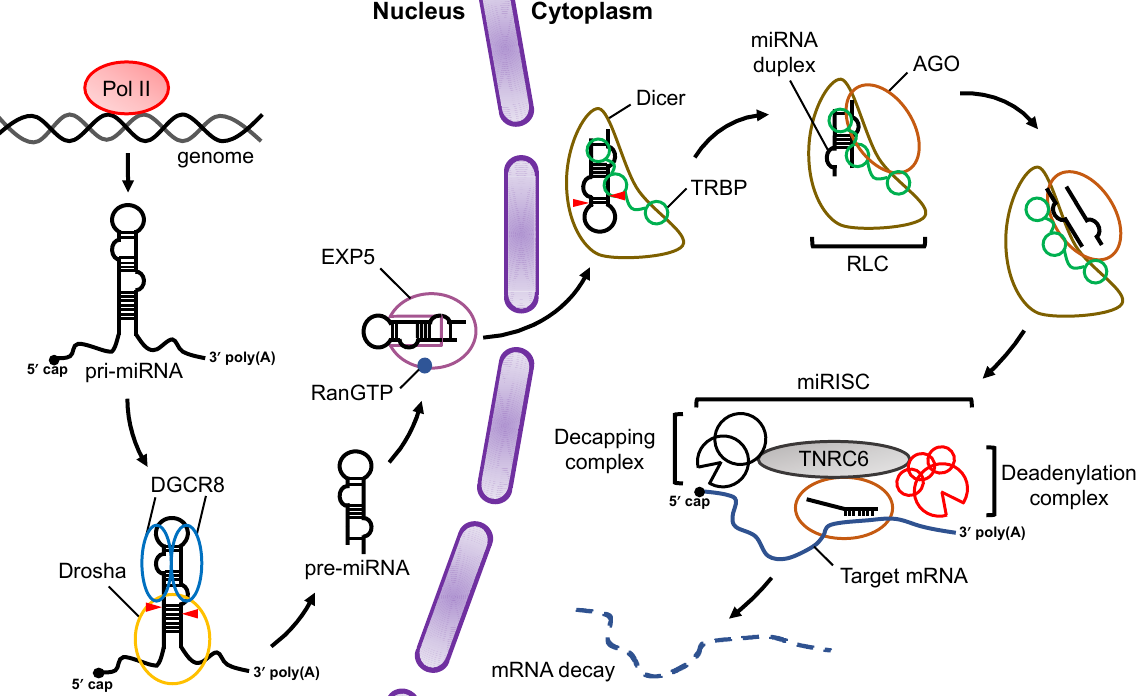
Figure 1. Overview of miRNA biogenesis and the RNA silencing pathway. Pri-miRNAs are transcribed from the genome by Pol II. In the nucleus, pri-miRNA is cleaved by a microprocessor complex consisting of Drosha and DGCR8 to produce pre-miRNA, which is then transported from the nucleus to the cytoplasm by EXP5 coupled with GTP-bound Ran (RanGTP). Cleavage of pre-miRNA is performed by Dicer and its cofactor, TRBP, in a canonical miRNA biogenesis pathway. After pre-miRNA cleavage, the miRNA duplex is loaded onto AGO proteins through formation of the RLC complex. The mature miRNA guides the RISC complex to target mRNAs that are complementary to the seed region of miRNA. Recruitment of the TNRC6 protein induces the destabilization and translational repression of the target